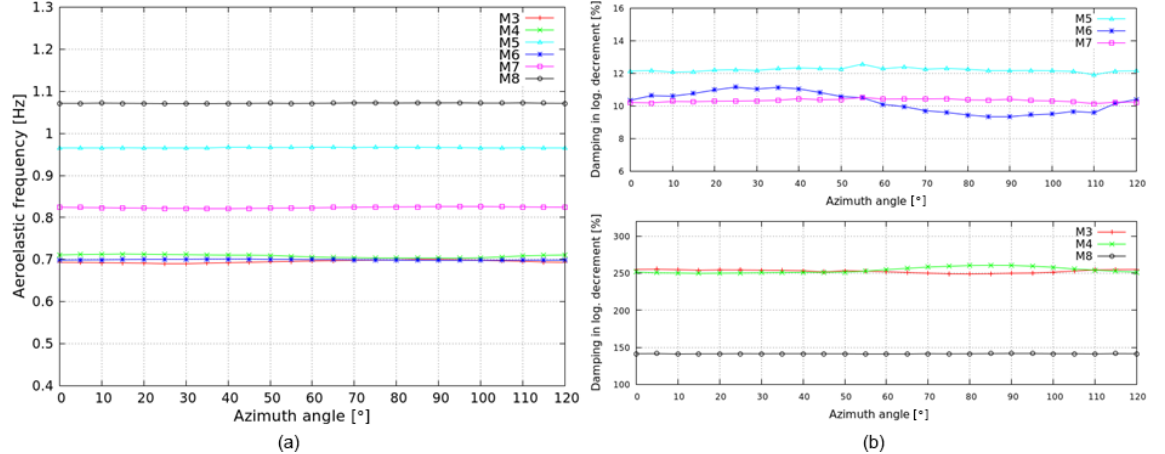
Figure 16. (a) Modal frequency and (b) modal damping of rotor modes versus azimuth angle at U = 42 . 5ms − 1 and yaw = 0 ◦ (unsteady aerodynamics based on the ONERA